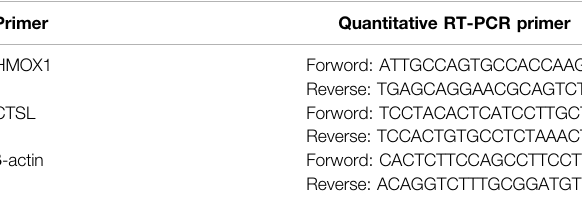
TABLE 2 | The primer sequences for